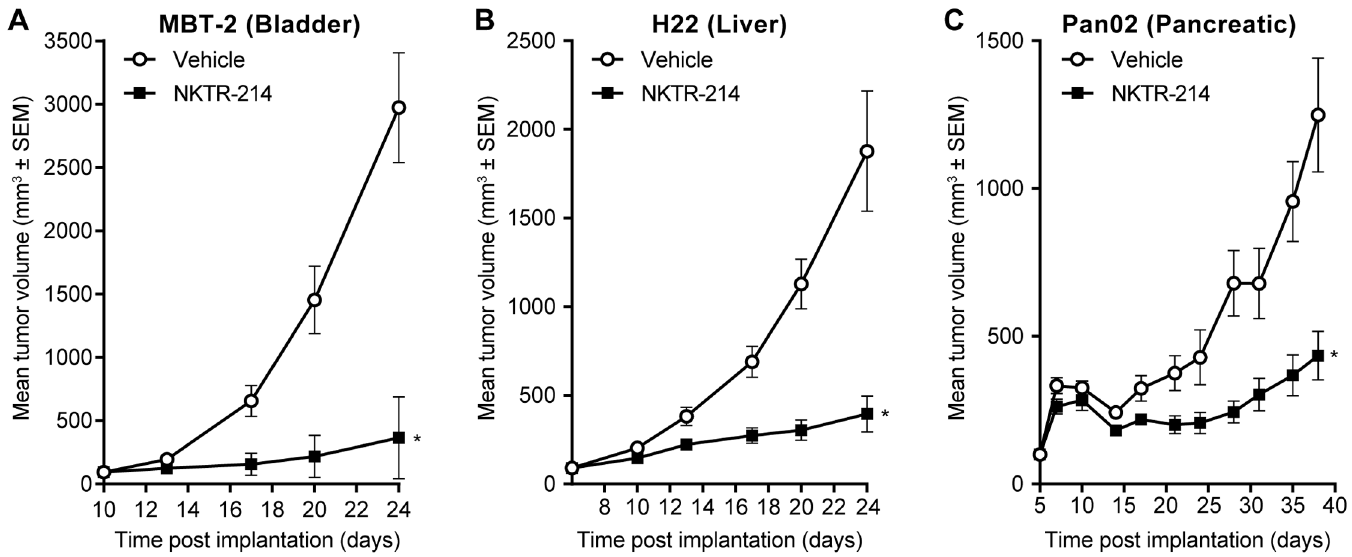
Fig 12. NKTR-214 is consistently effectiveacross severalestablished mouse tumor models. Examplesshown belowincludeA. bladder(MBT-2), B. liver (H22), and C. pancreatic(Pan02) for single-agent NKTR-214 comparedto vehicle. In all cases, tumors were grown to large size, 80-100mm 3 , N = 7/ group; NKTR-214 0.8 mg/kg q9dx3. * , P < 0.05 (unpairedt-test).